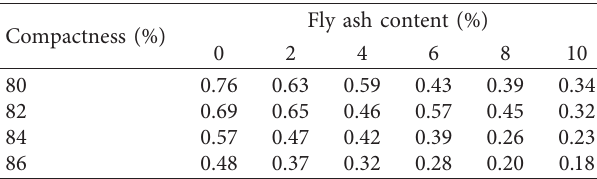
Table 1: Compression coefficient (MPa − 1 ) of modified fly ash soil with different compaction degrees.